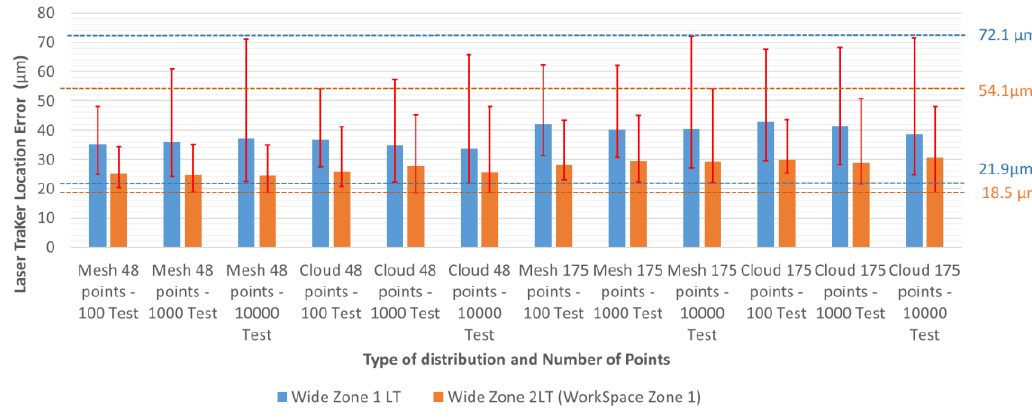
Figure 10. Error of the LT location in the wide zone. One zone vs. two zones with different